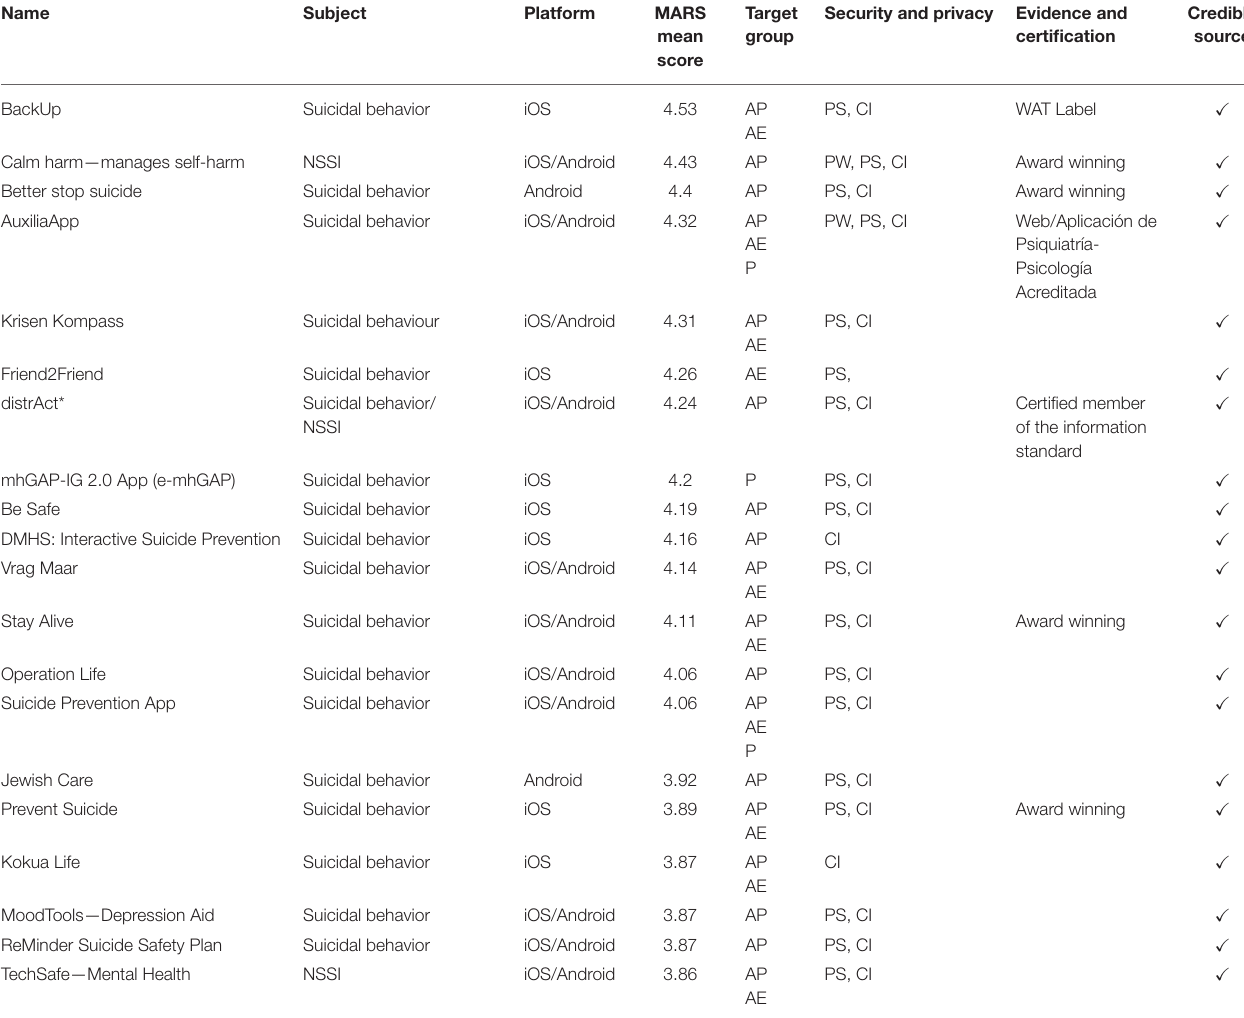
TABLE 2 | Mean rating scores, features and functions of high-quality MHA for suicide/NSSI